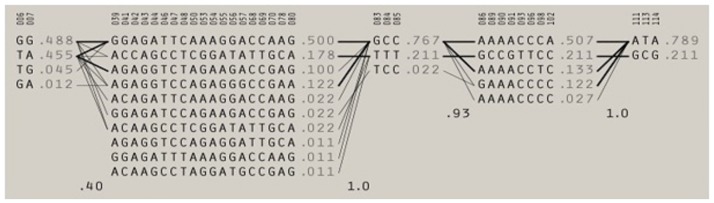
Haplotype blocks.Haplotype blocks with population frequencies displayed next to each haplotype. Lines represent the most common crossings between block (thicker lines are more common) beneath which the value of multiallelic D’ is shown, measuring the level of linkage disequilibrium (LD) between blocks. Greater recombination is denoted by a value closer to zero.